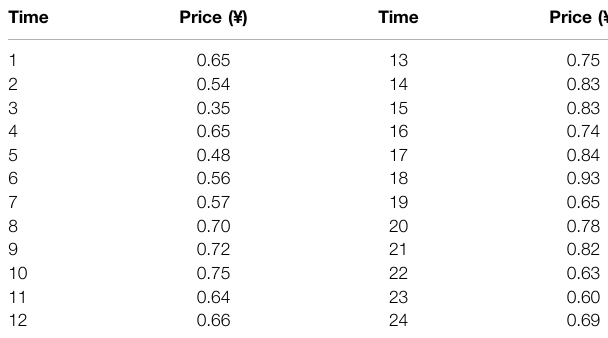
TABLE 1 | Time-of-use electricity